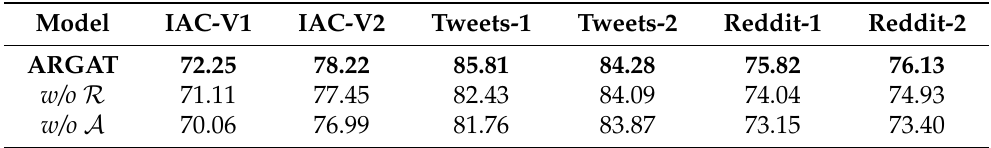
Table 5. Accuracy results of ablation study. The results of the proposed model are in bold. R denotes the RGAT structure, A denotes affective GCN